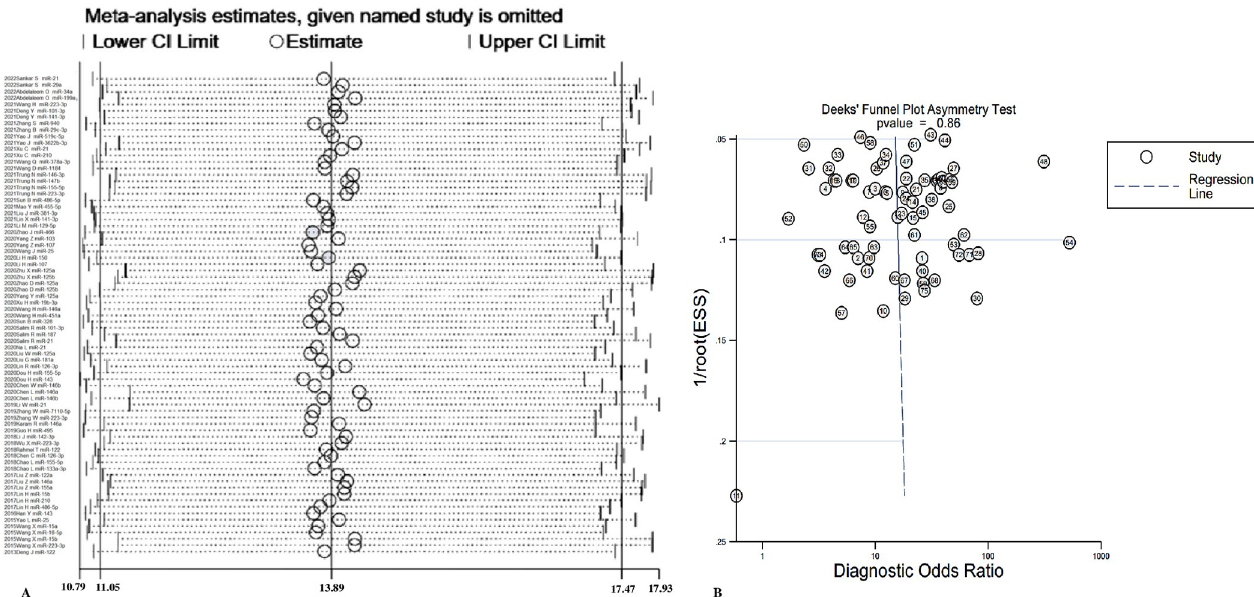
Fig 6. Sensitivity analysis and publication bias of the individual trials on the results TmiRs. (A) Sensitivity analysis for the result of TmiRs, (B) Funnel plot for the assessment of potential publication bias. DOR = diagnostic odds ratio, ESS = effective sample size, miR = mircoRNA, TmiRs = total mixed miRNAs.